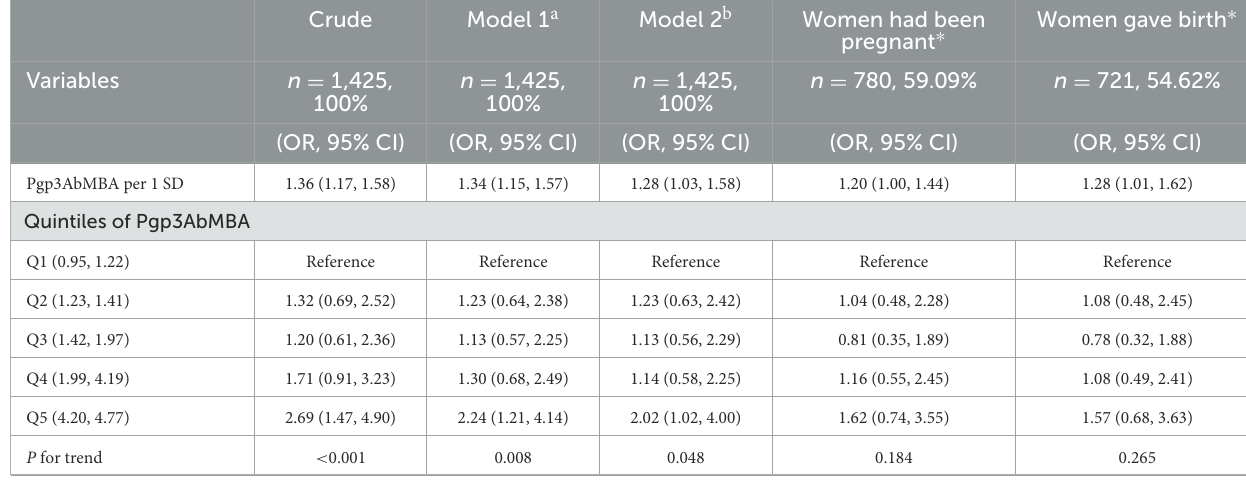
TABLE 2 Logistic regression of Pgp3AbMBA for the risk of infertility. Crude Model 1 a Model 2 b